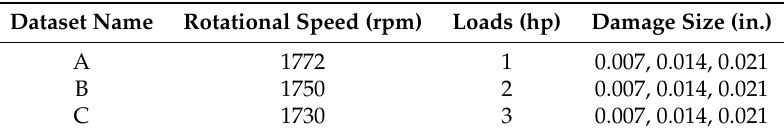
Table 2. Dataset details under di ff erent operating conditions.